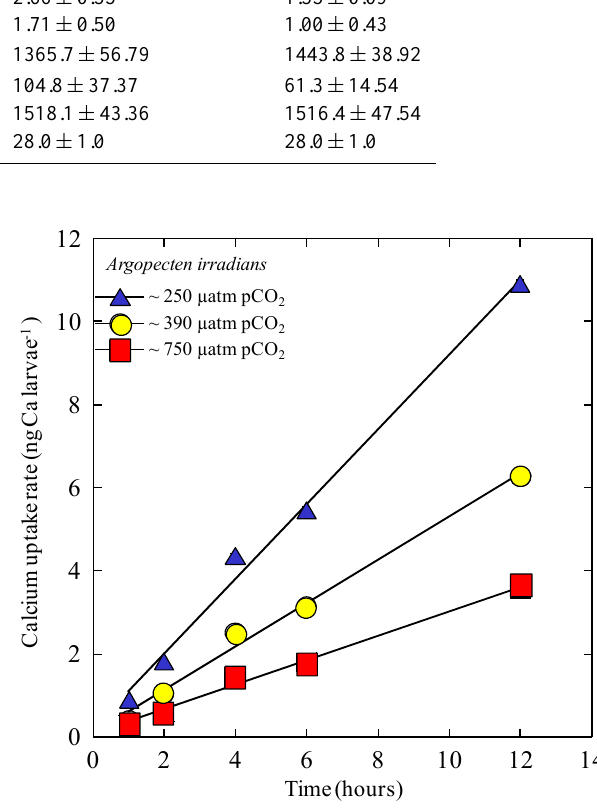
Fig. 2. Mean ( ± 1SD) calcium uptake rates over 12h for Ar- Figure 2. Mean (± 1 SD) calcium uptake rates over 12 h for Argopecten irradians larvae 950 (veligers from day 12). Larvae were grown under CO 2 concentrations of approximately 951 gopecten irradians larvae (veligers from day 12). Larvae were 250, 390, and 750 µatm CO 2 (Table 2), n = 4 per treatment. Regressions corresponding 952 grown under CO 2 concentrations of approximately 250, 390, and to each treatment are listed in legend. Regression are 250 µatm CO 2 , y = 0.19 + 0.90 x 953 750µatm CO 2 (Table 2), n = 4 per treatment. Regressions corre- (R 2 =0.99), ~ 390 µatm CO 2 , y = 0.05 + 0.52 x (R 2 =0.99), and ~ 750 µatm CO 2 , y = 954 sponding to each treatment are listed in the legend. Regressions are 0.06+ 0.29 x (R 2 =0.99). 955 956 250µatm CO 2 , y = 0 . 19 + 0 . 90 × ( R 2 = 0 . 99), ∼ 390µatm CO 2 , y = 0 . 05 + 0 . 52 × (R 2 = 0.99), and ∼ 750µatm CO 2 , y = 0 . 06 + 0 . 29 × (R 2 = 0 .